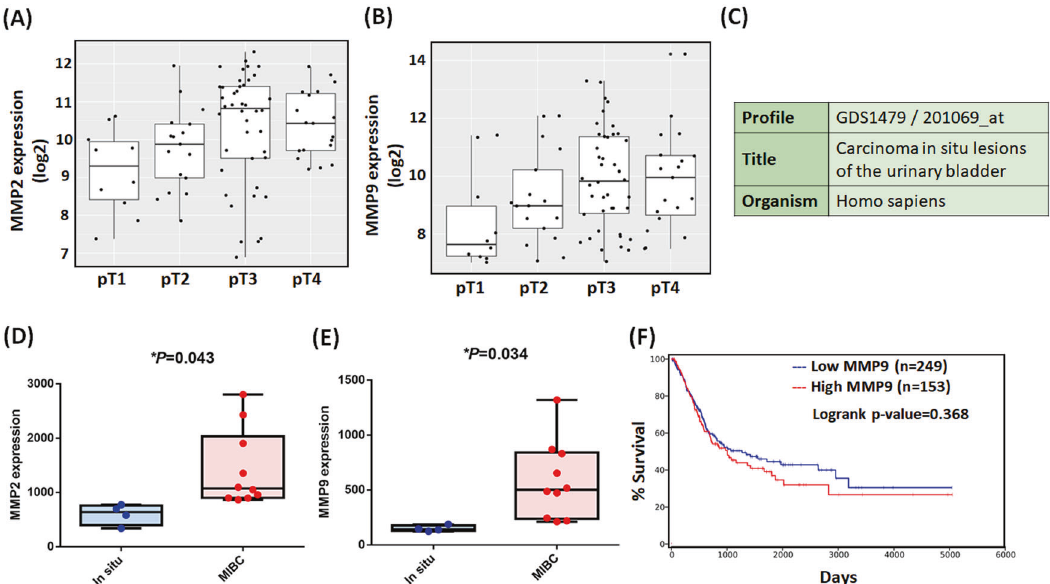
Fig. 3 MMP2 and MMP9 mRNA expression in BC tissue. A , B The GENT2 web server was used to analyze correlations between MMP2 and MMP9 gene expression and primary tumor status. C – E The BC pro fi les (GDS1479) in GEO con fi rmed the MMP2 and MMP9 mRNA level in carcinoma in situ tissues ( N = 4) and MIBC tissues ( N = 10). F OS rates in patients with BC with high ( N = 153) and low ( N = 249) MMP9 expression levels were analyzed using the OncoLnc web server. All data are expressed as means ± SDs in triplicate samples. * P < 0.05, ** P < 0.01, *** P < 0.001, and **** P < 0.0001 relative to the pT1, In situ, or Low MMP9 group.